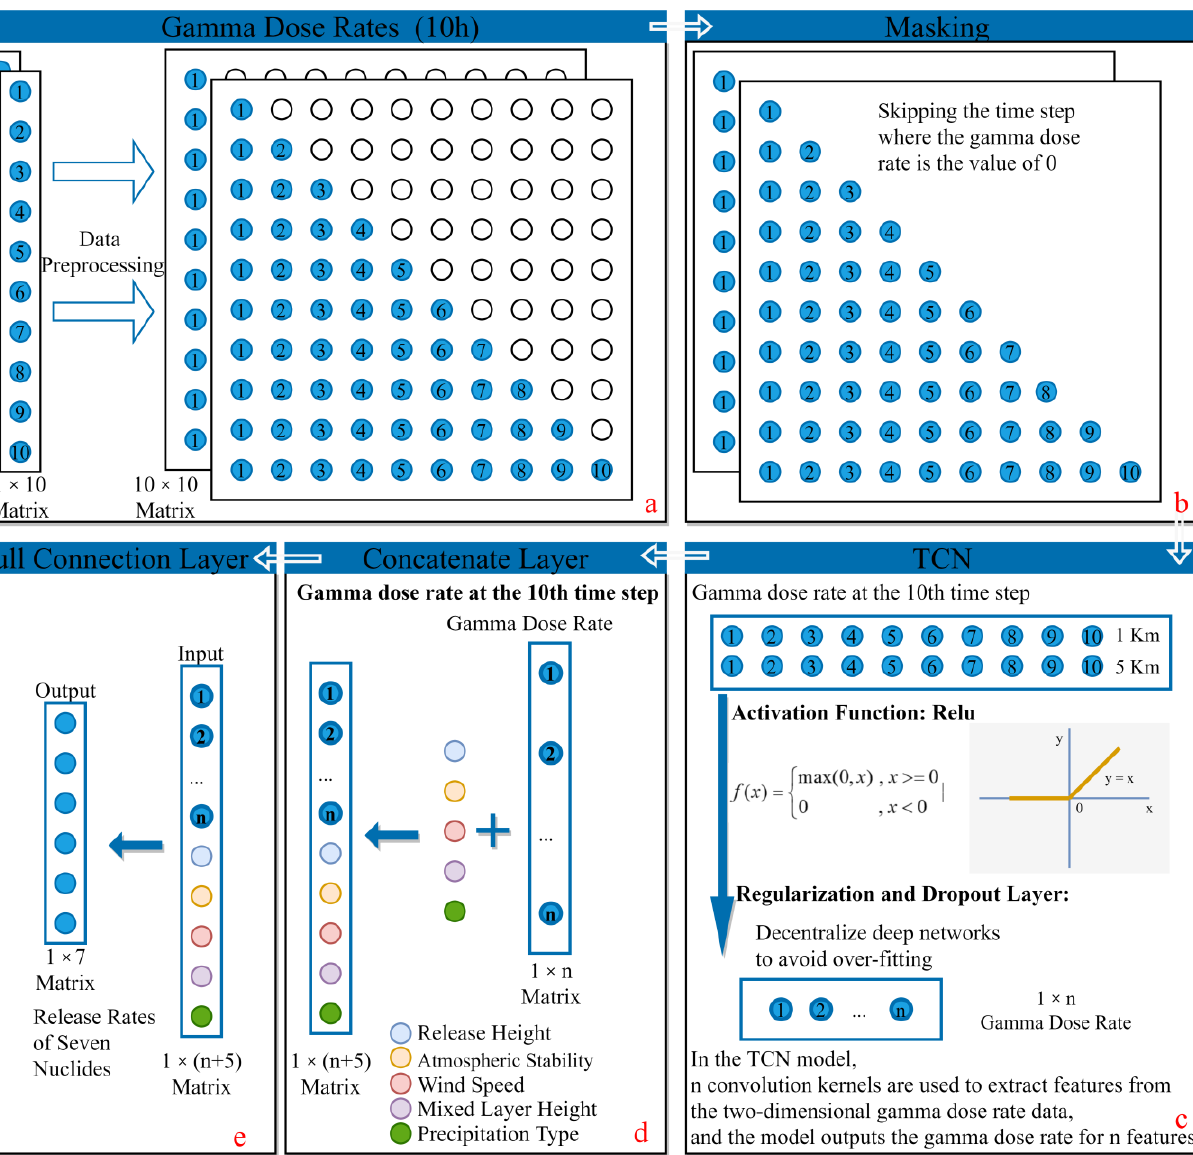
Figure 3. A multi-nuclide source term inversion model for nuclear accident based on a temporal convolutional neural network (TCN). (a) Input unit; (b) Masking unit; (c) TCN model; (d) Concatenate layer; (e) Full Connection layer